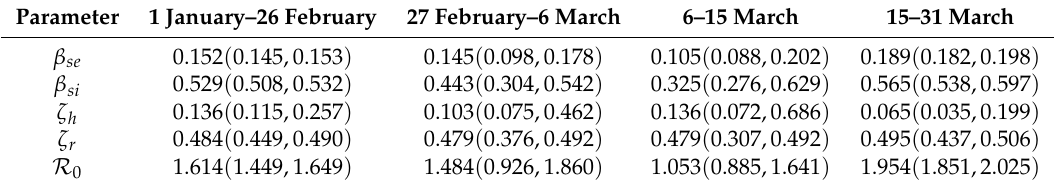
Figure 3. The accumulated reported cases and numerical values with 95% confidence intervals. Table 2. Parameter values with 95% confidence intervals for the model in Equation